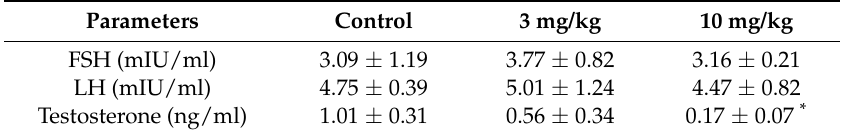
Table 2. Summary of hormone levels in rats (Mean ± SD).